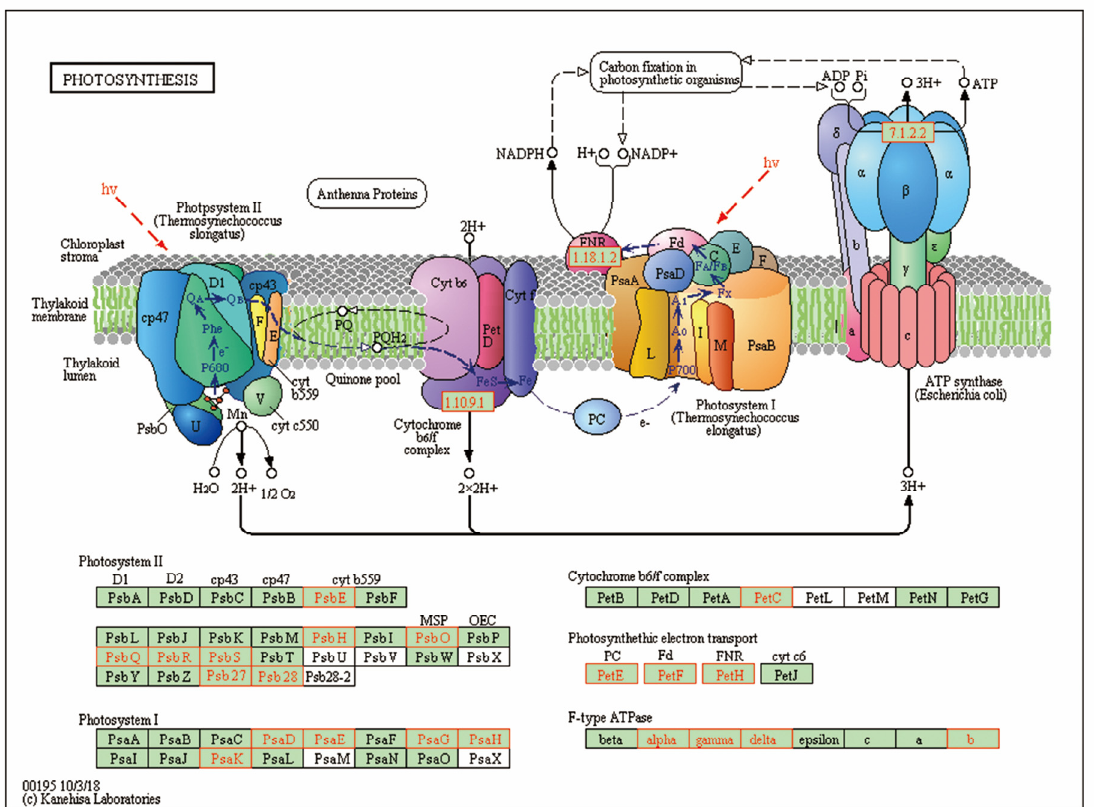
Figure 9. Di ff erentially accumulated proteins (DAPs) involved in photosynthesis pathway. The known Figure 9. Differentially accumulated proteins (DAPs) involved in photosynthesis pathway. The pathways were obtained from KEGG database. Red borders indicate di ff erentially accumulated proteins known pathways were obtained from KEGG database. Red borders indicate differentially in OsCpn60 β 1 mutants. Green background borders indicate proteins which were unidentified identified accumulated proteins in OsCpn60 β 1 mutants. Green background borders indicate proteins which in WT but not in OsCpn60 β 1 mutants. White background borders indicate proteins which were not were unidentified identified in WT but not in OsCpn60 β 1 mutants. White background borders identified in both WT and OsCpn60 β 1 indicate proteins which were not identified in both WT and OsCpn60 β 1 mutants.